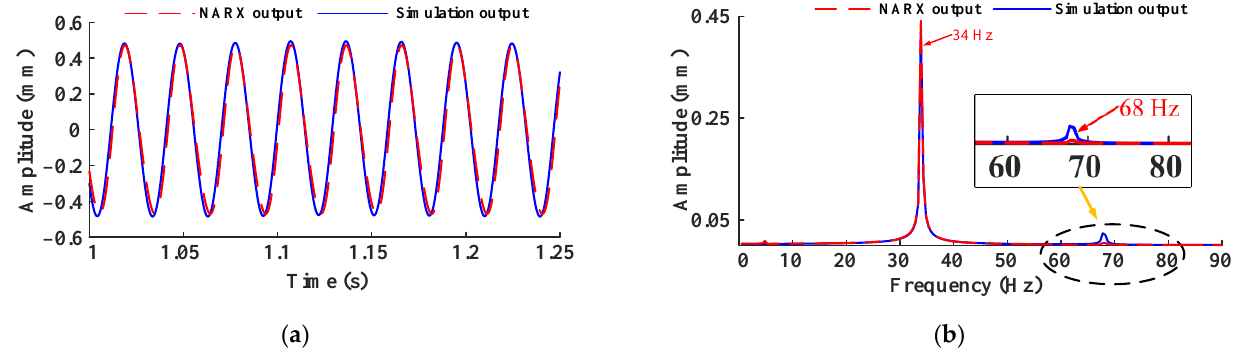
Figure 10. Response of the disk in x -direction ( ω = 213.6 rad/s): ( a ) time-domain; ( b ) frequency Figure 10. Resp onse of the disk in x -direction ( main. Figure 10. Resp onse of the disk in x -direction ( Figure 10. Resp onse of the disk in x -direction ( main.